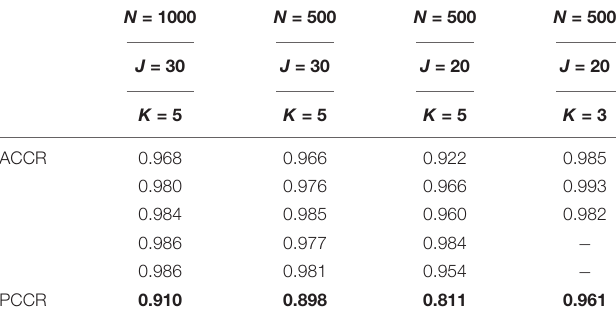
TABLE 2 | ACCRs and PCCRs in simulation studies I and II.